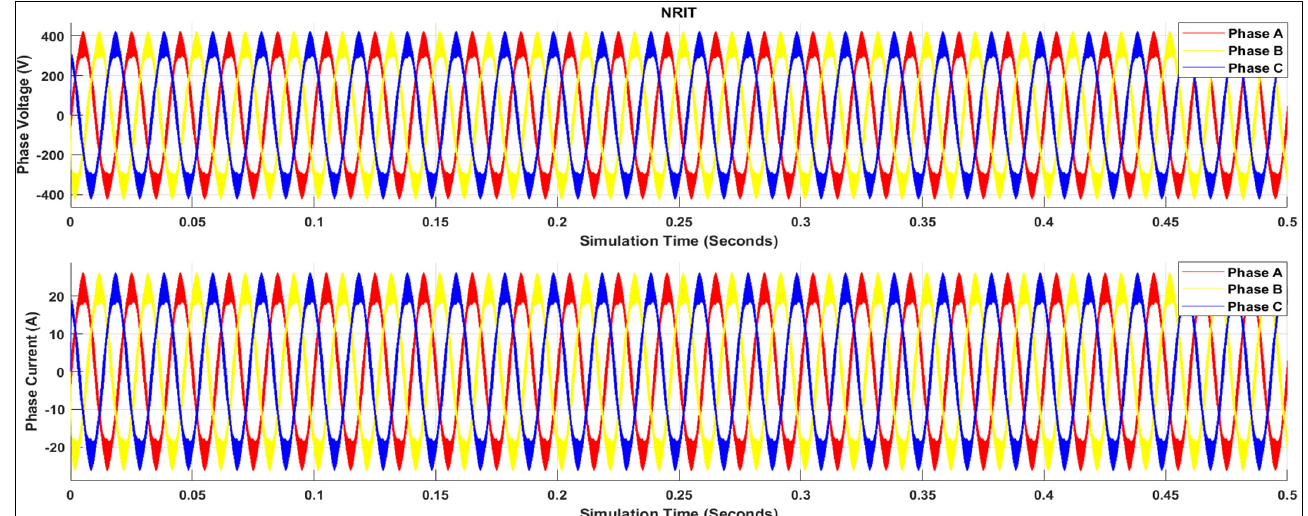
Figure 11. Case study 1 three-phase grid voltages and current with NRIT.